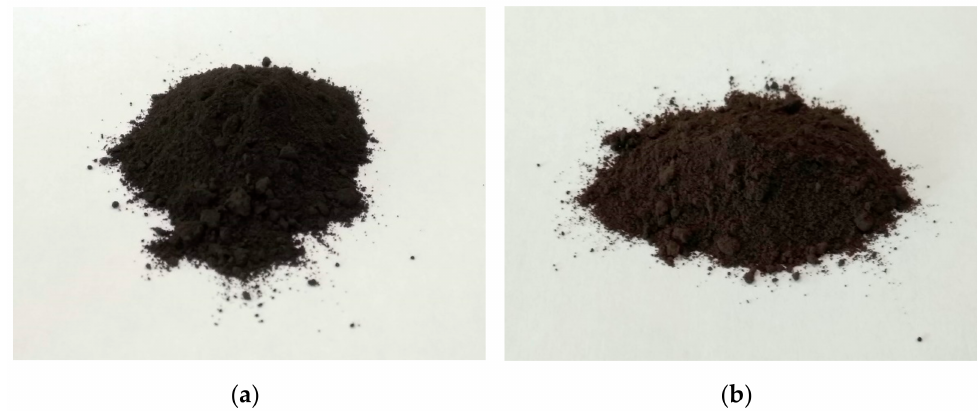
Figure 2. Samples of raw materials: ( a ) manganese ore from the Bogach deposit; ( b ) manganese ore from the Zhaksy